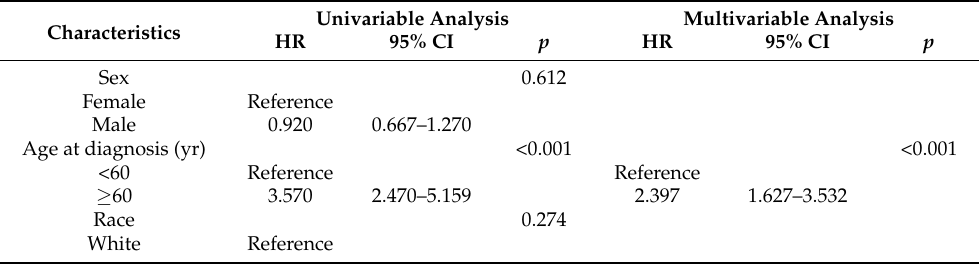
Table 2. Univariable and multivariable Cox proportional hazard model analysis of overall survival in patients with primary bile duct and ampullary neuroendocrine